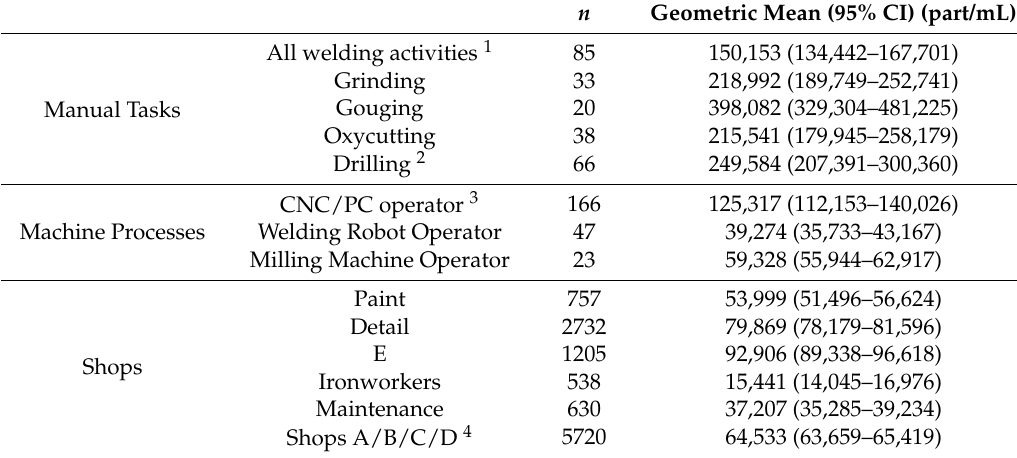
Table 2. Geometric mean and 95% confidence intervals for manual tasks, machine processes, and shop surveys.